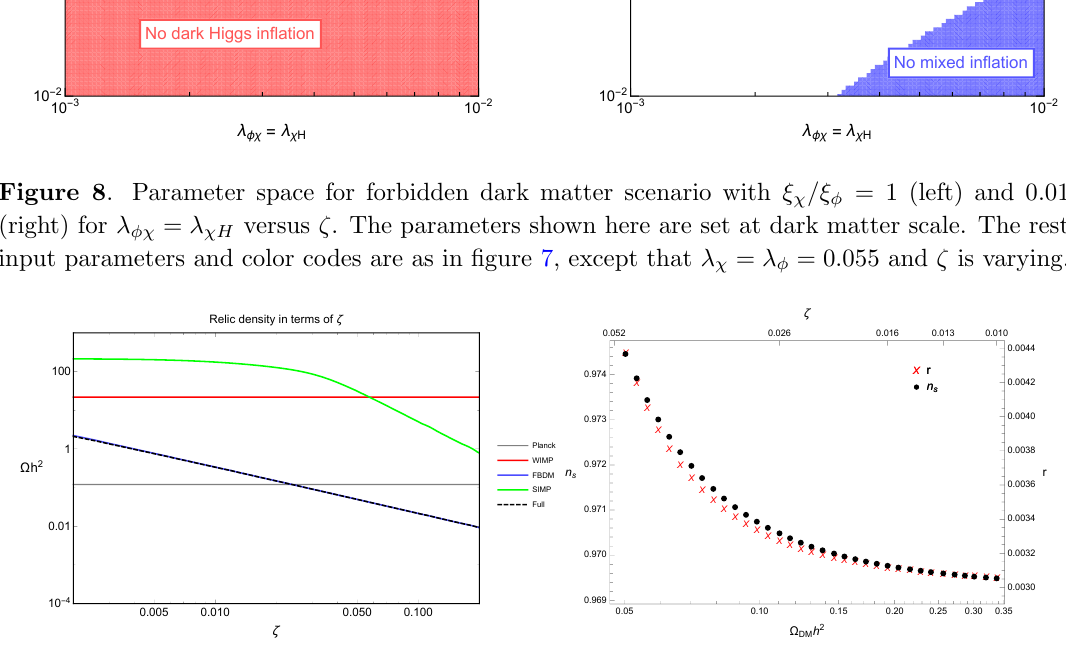
Figure 9 . (Left) Relic densities for each dark matter components. (Right) Relic density in the plane of spectral index and tensor-to-scalar ratio. The parameters are chosen as follows: sin (cid:18) = 10 (cid:0) 5 , " = 10 (cid:0) 4 , g X = 0 : 1, m h 0 = 0 : 16GeV, m (cid:31) = 0 : 1GeV, (cid:21) (cid:30) = (cid:21) (cid:31) = 0 : 055, (cid:21) (cid:30)(cid:31) = (cid:21) (cid:31)H = 0 : 006, thus m Z 0 = 0 : 14GeV. The grey horizontal solid line on left represents the Planck data for the relic